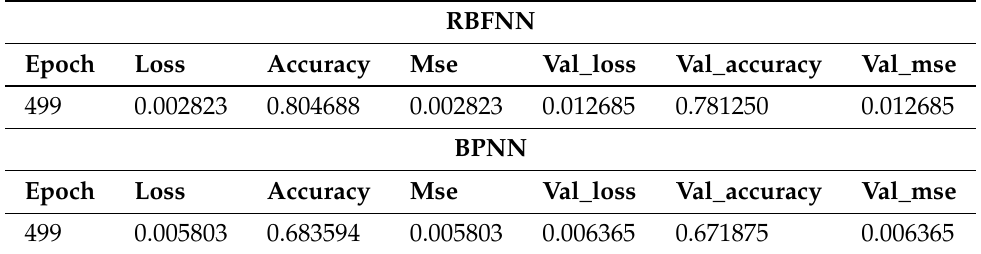
Table 15. RBFNN and BPNN